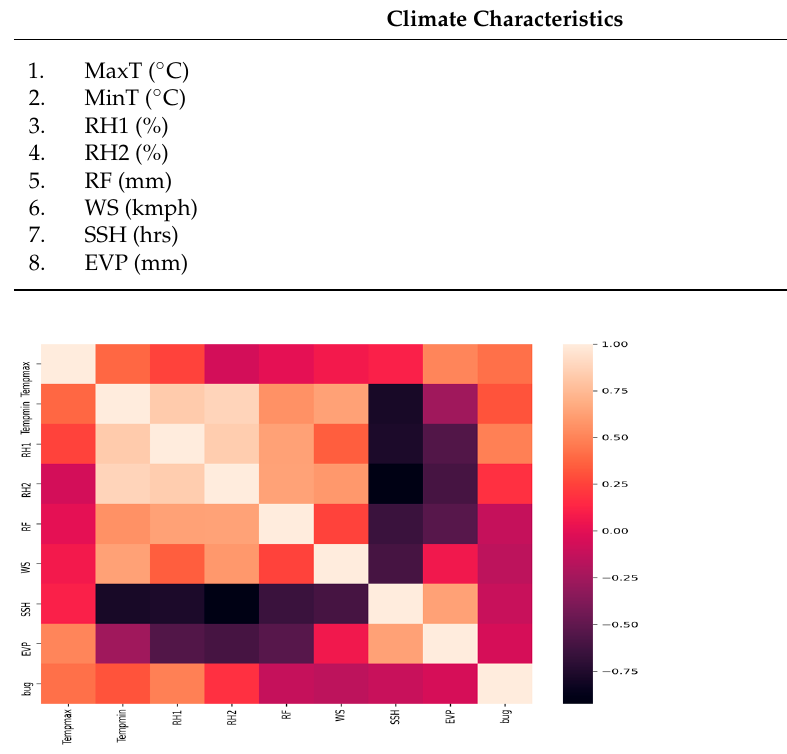
Table 7. Climate characteristics used in Experiment 2.